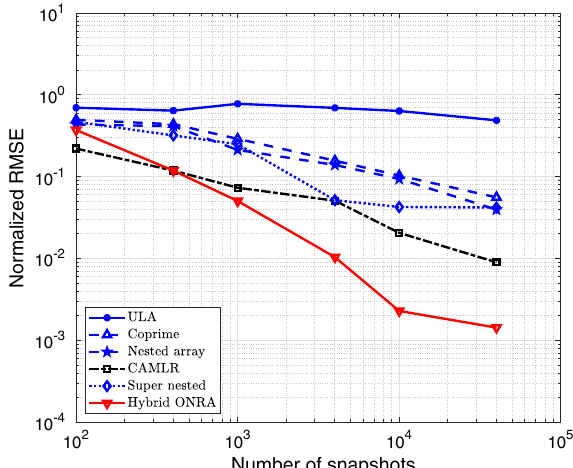
Fig. 3 RMSE of the CU-RIS channel versus the number of snapshots when the paths are closely spaced (transmit power 10 =